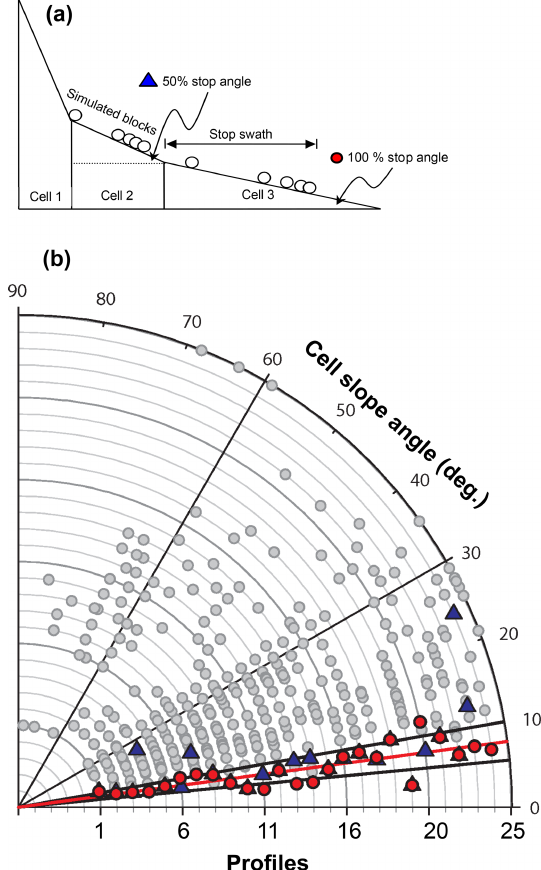
Figure 7. (a) Schematic illustration of the CRSP-modeled slope cells and explanation of the terms “ x % stop angle” (e.g., 50% stop angle is the angle of the slope cell where 50% of the blocks stop) and “stop swath” (the farthest distance along the slope where 100% of the blocks stop). (b) Slope gradients of slope cells and gradi- ents at stop angles. Tangential axes ( x and y axes) denote simulated profile numbers 1 to 25. Radial axis denotes the slope angles. Gra- dients for all cells per profile are plotted on an arc between 0 and 90 degrees: red circles are 100% stop angles (slope angle of the profile cell at which cumulated 100% of simulated blocks stop); blue triangles are 50% stop angles; gray circles are all other cells in the profile. For example, the cells along profile 16 have slope an- gles that vary between 8 and 36 ◦ ; the 100% stop angle is 11 ◦ (red circle) and the 50% stop angle is 8 ◦ (blue triangle). The red line represents the mean of all 100% stop angles for all profiles at 7.7 ◦ and the thick black lines represent its SD of 2.3 ◦